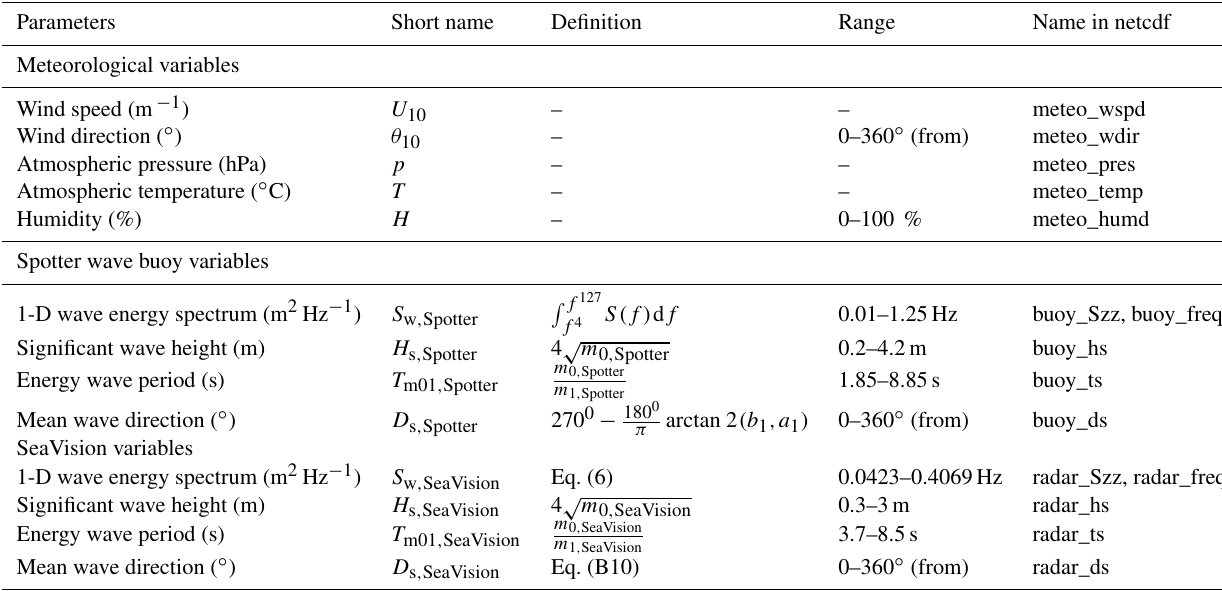
Table C1. Definition of all the parameters in the paper and